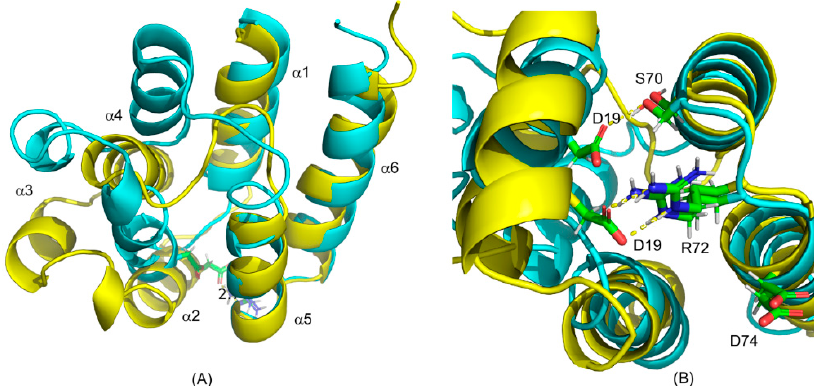
Figure 3. Superposition of CS-Rosetta structural models of the free and ERK2-bound forms of PEA-15. ( A ) Superimposition of the free form (yellow) with the bound-form models (cyan). The ERK2-bound PEA-15 displays minimum changes in helices α 1, α 5, and α 6, but significant conformational change in helices α 2, α 3, and α 4. ( B ) Positions of charge-triad residues in the free (yellow) and ERK2-bound models (cyan). The D19 residue moves significantly, while the R72 and D74 residues mostly stay at their original positions. The hydrogen-bonding interactions between the D19 and R72 residues in the free-form structure is replaced by the D19–S70 hydrogen bond in the ERK2-bound structure.